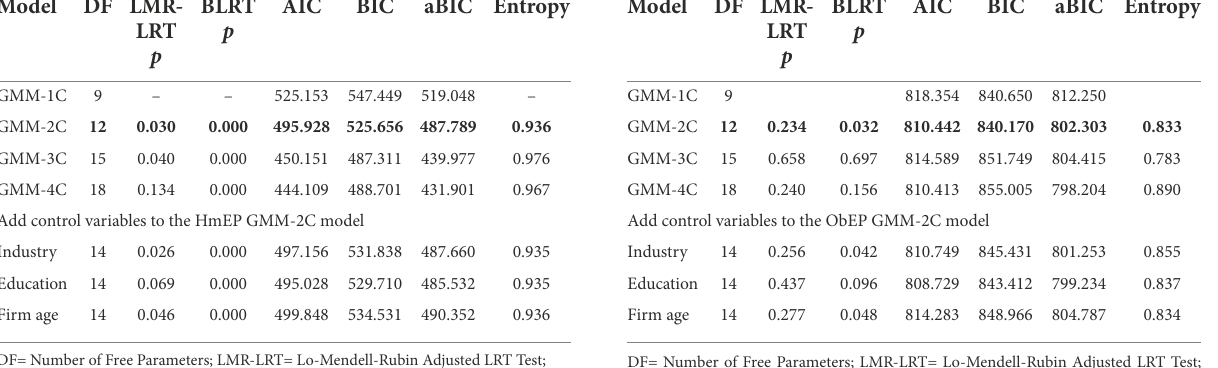
TABLE 2 Comparison of fit degree of latent variable growth models of different classifications of HmEP. Model